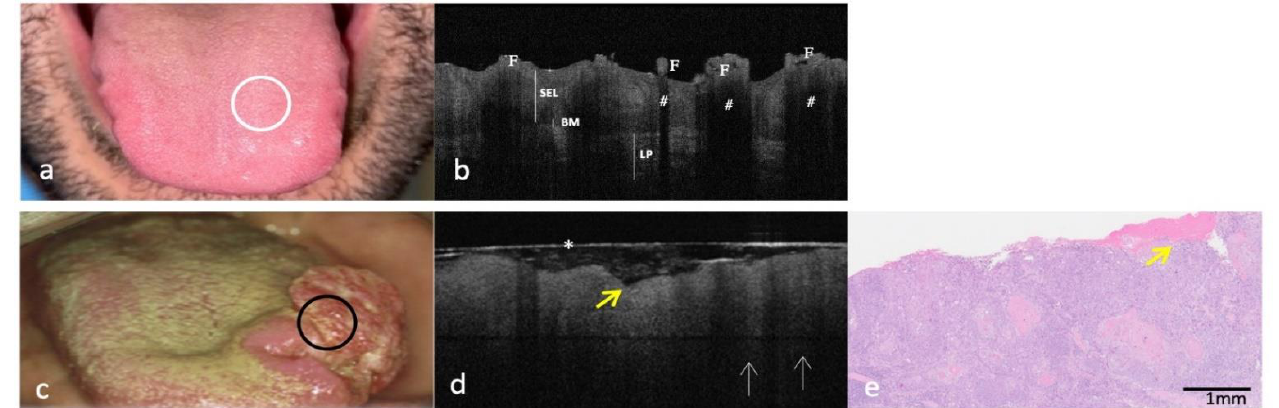
Figure 1. Clinical, OCT and histopathology images of a case of OSCC on the dorsal surface of the